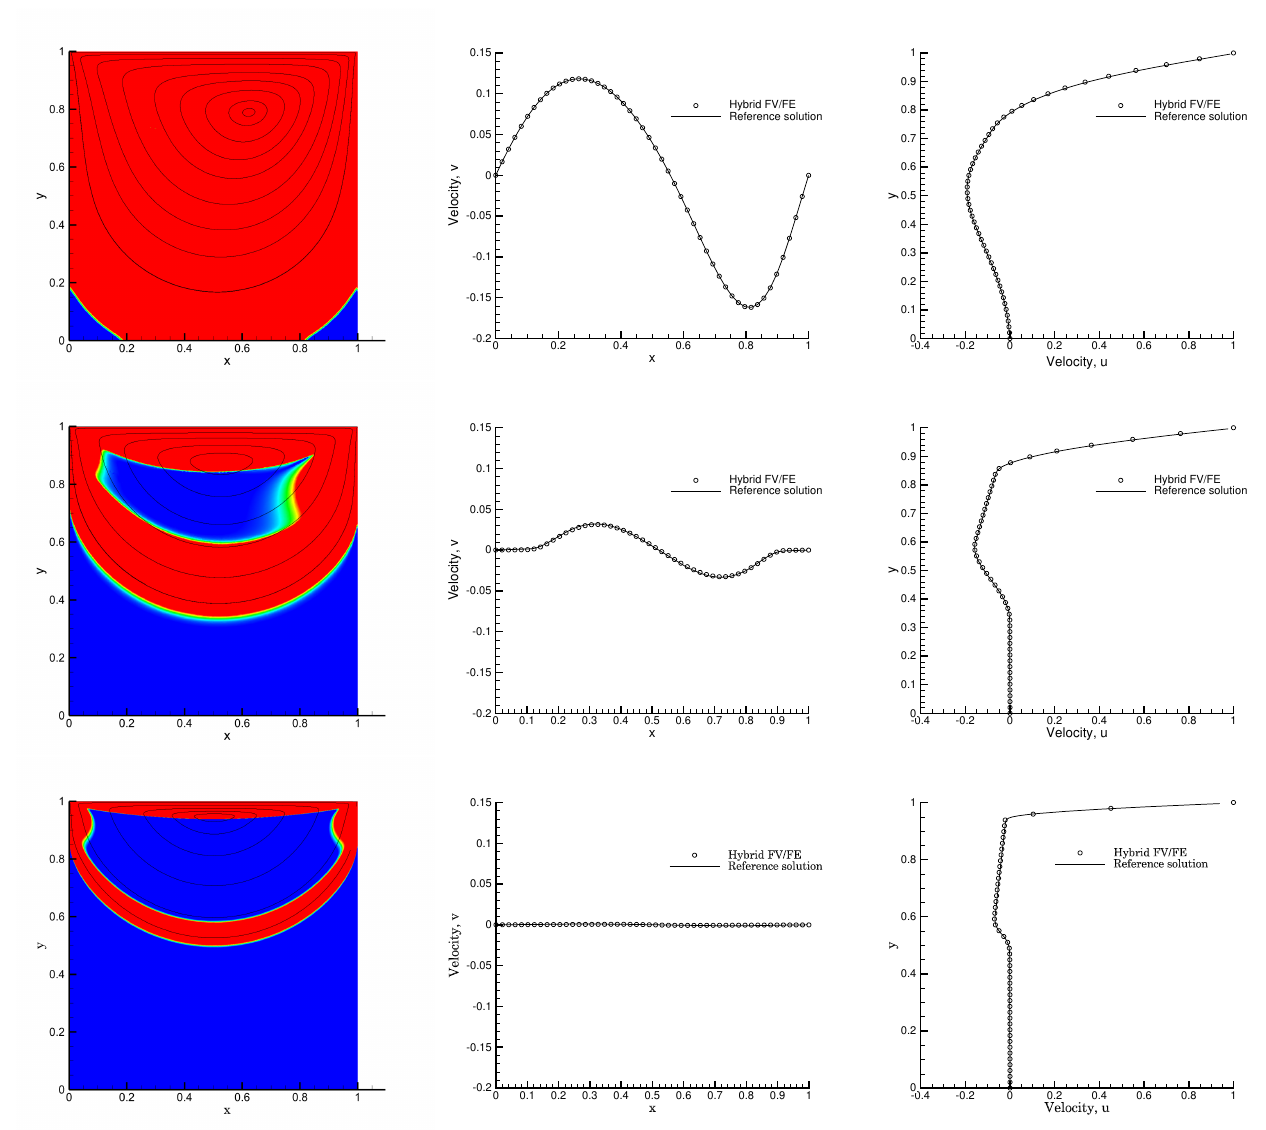
Figure 7. Lid-driven cavity flow with yield stress. Comparison of the numerical solution obtained using the hybrid FV/FE method (circles) with the analytical solution of the Herschel–Bulkley model obtained from [89] (solid line). Left: contour plot of the ratio σ / σ y . Center and right: 1D cuts of the velocity field in x = 0.5 and y = 0.5 and reference solution obtained by considering the consistency parameter k = 10 − 2 . Bingham numbers: Bi = 1 ( top ), Bi = 10 ( middle ) and n = 100 ( bottom